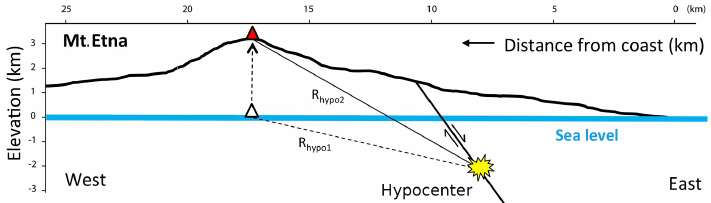
Figure 4. A topographic profile of Mt. Etna shown to scale, extending from the western side of the volcano to the eastern coast (Ionian Sea). Using a hypothetical fault, it can be demonstrated how the source-to-site distance increases ( R hypo2 >R hypo1 ) if the site is defined on the topographic surface (red triangle) compared to the sea level (clear triangle).